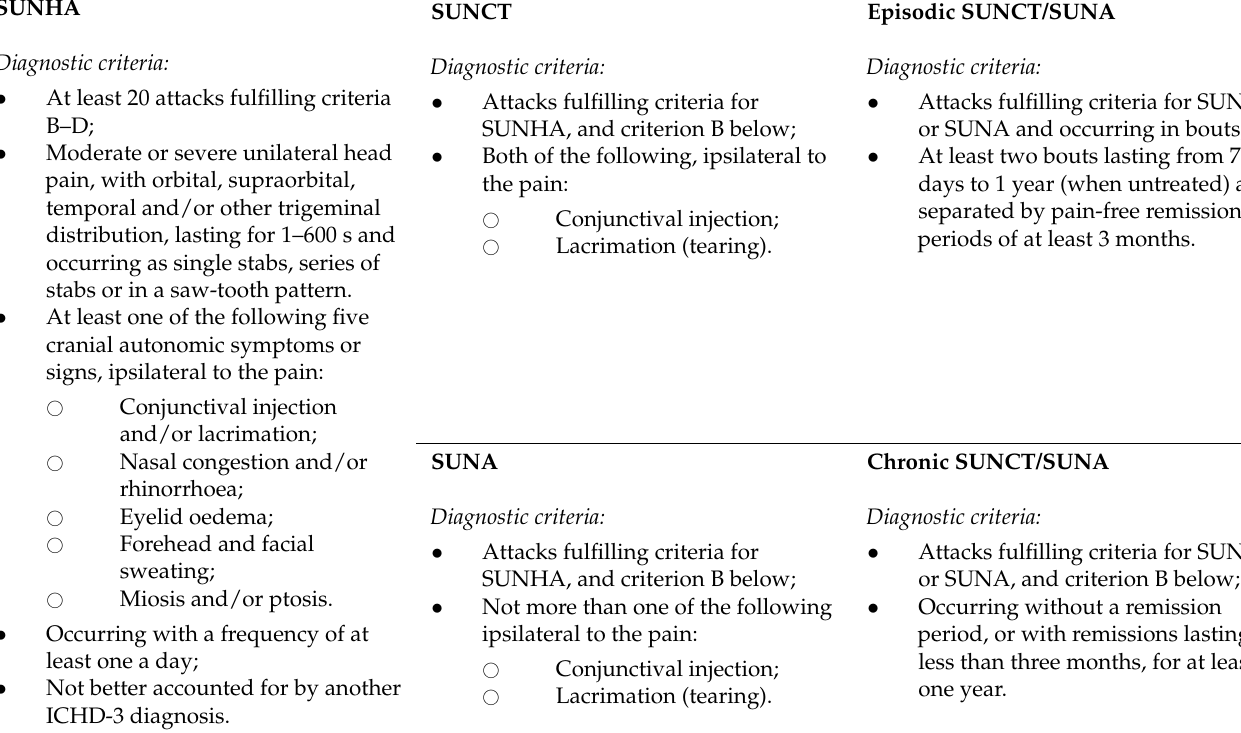
Table 3. Diagnostic criteria for SUNHA